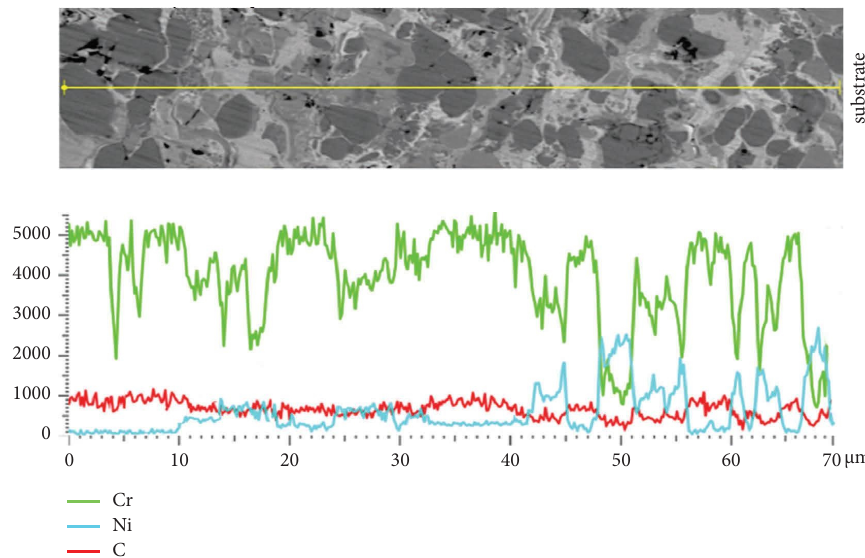
Figure 8: SEM images of the cross section and element depth distribution of the gradient coating Cr